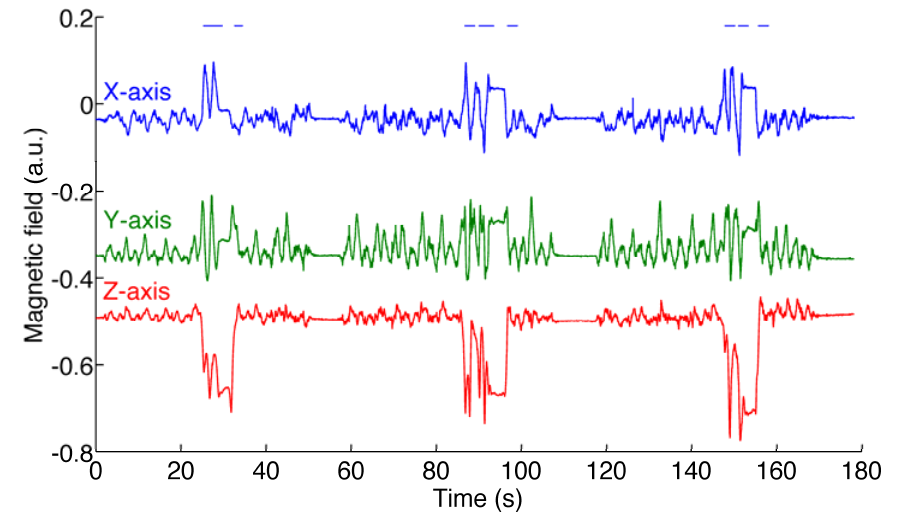
Figure 4. Components of the ground-truth reference magnetic field. The horizontal bars at the top of the plot show the time intervals of sojourns in the higher-order state model (dynamic test).